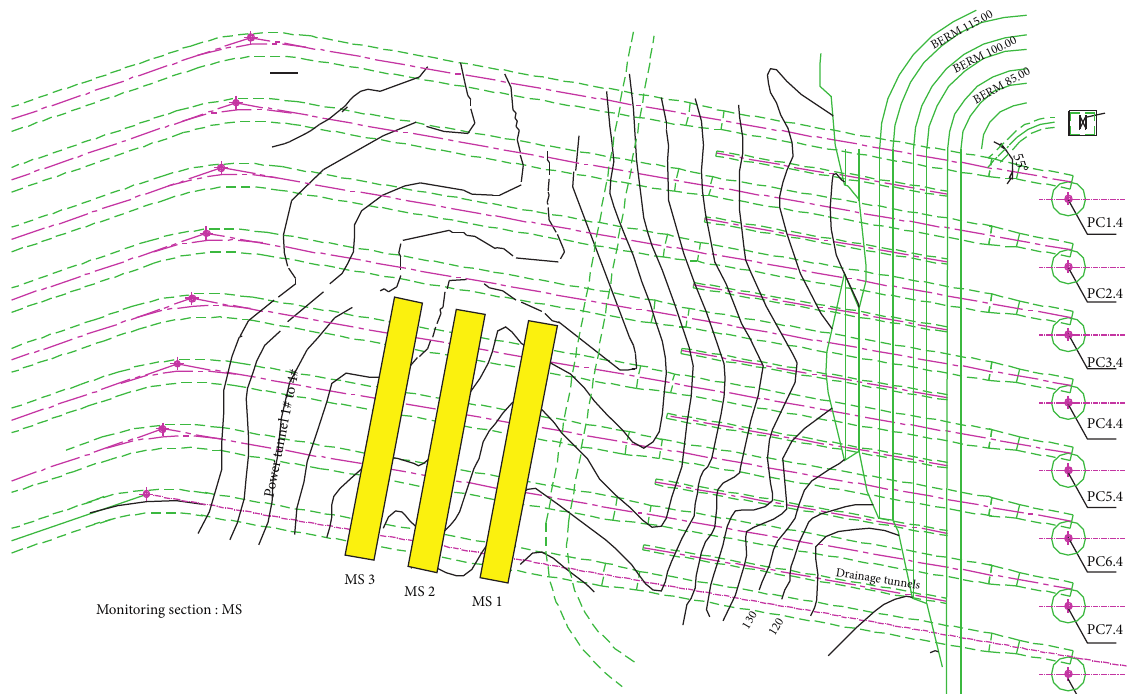
Figure 4: Three sections selected for in situ monitoring.